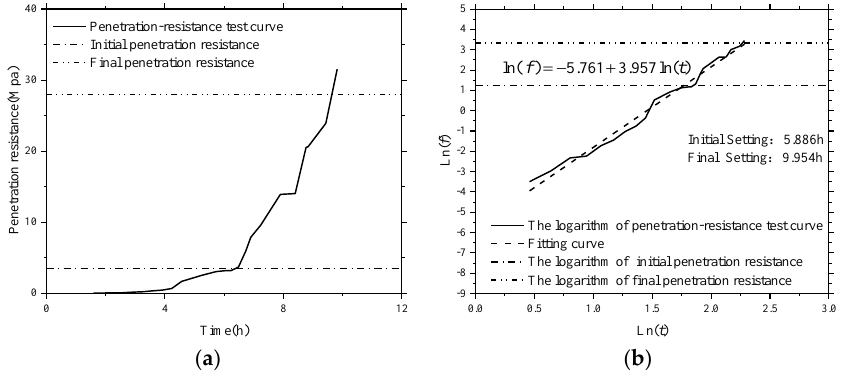
Figure 17. Typical penetration-resistance test results of SCC with 0% fly ash. ( a ) Penetration-resistance test curve; ( b ) the logarithm of penetration-resistance test curve.